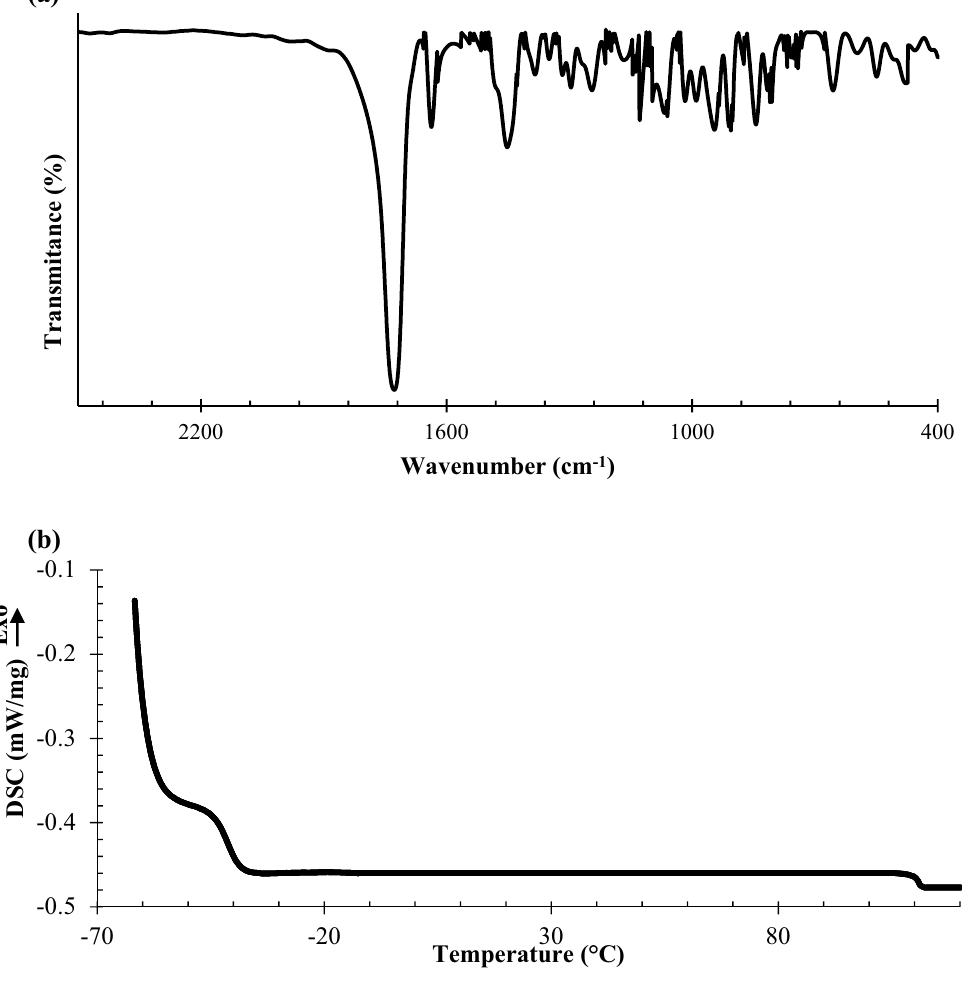
Figure 3. ( a ) FTIR spectrum and ( b ) DSC thermogram of the prepared